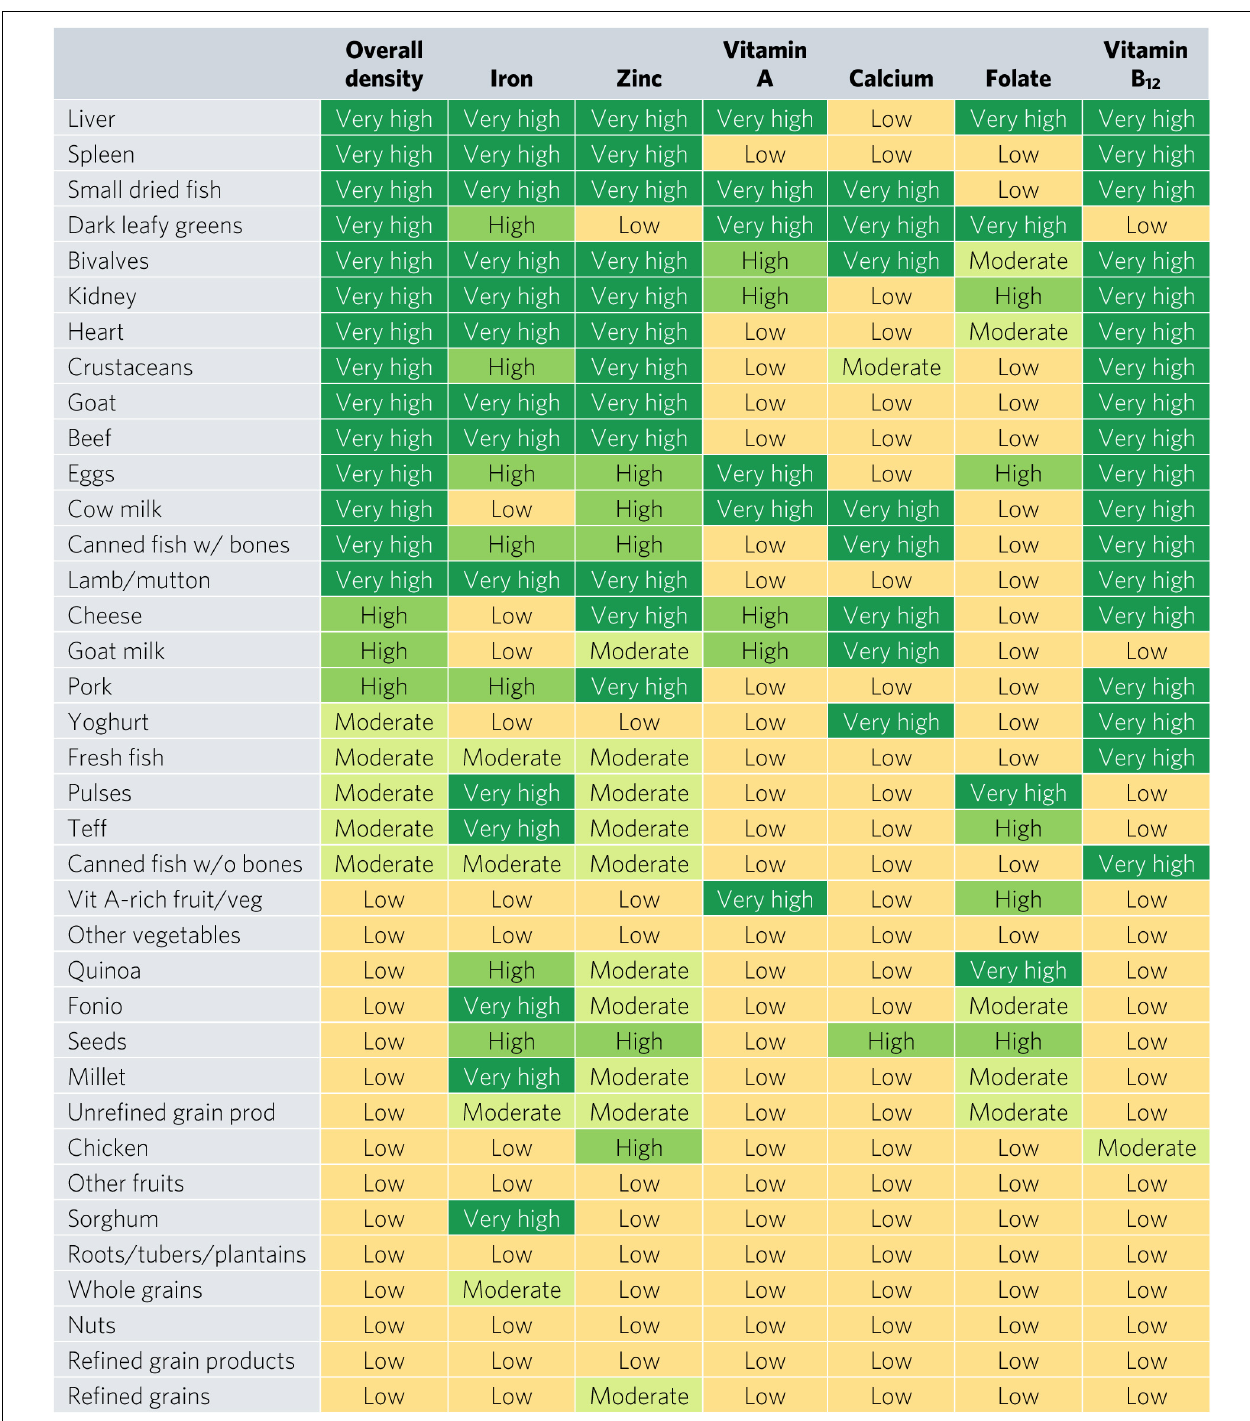
FIGURE 5 | Aggregate and individual micronutrient density scores for adults ≥ 25. Mod, moderate; prod, products; veg,